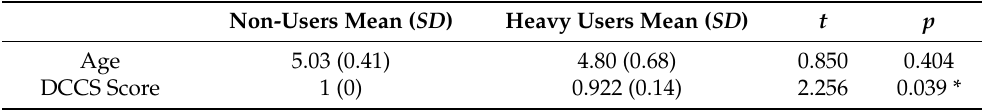
Table 1. Comparison of behavioral performance (correct rate) in the DCCS task.